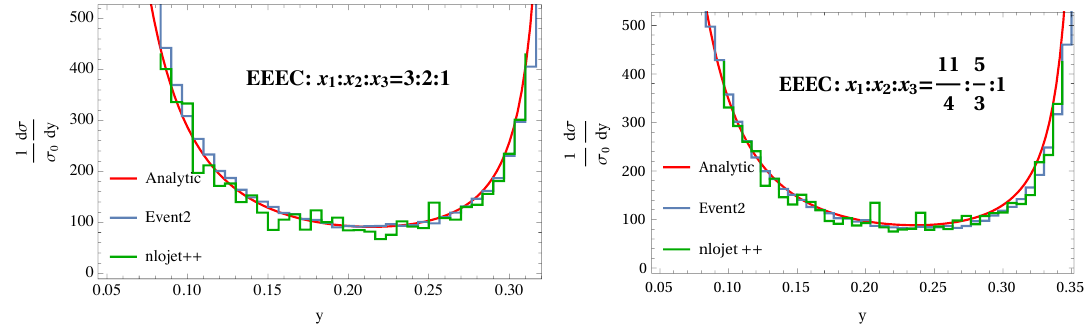
Figure 3 . Comparison of the analytic result with the numerical programs Event2 and NLOJet++ for { x 1 , x 2 , x 3 } = { 3 y, 2 y, y } and { x 1 , x 2 , x 3 } = { 11 y, 5 y, y } . Due to eq. (3.7), the kinematic spaces are 4 3 cutoff at y = 1 and y = 959 ≈ 0 . 36 respectively. Fifty billion points are sampled and the internal 3 2640 cutoff is set to 10 − 14 in Event2 . Ten billion events are generated in NLOJet++ .